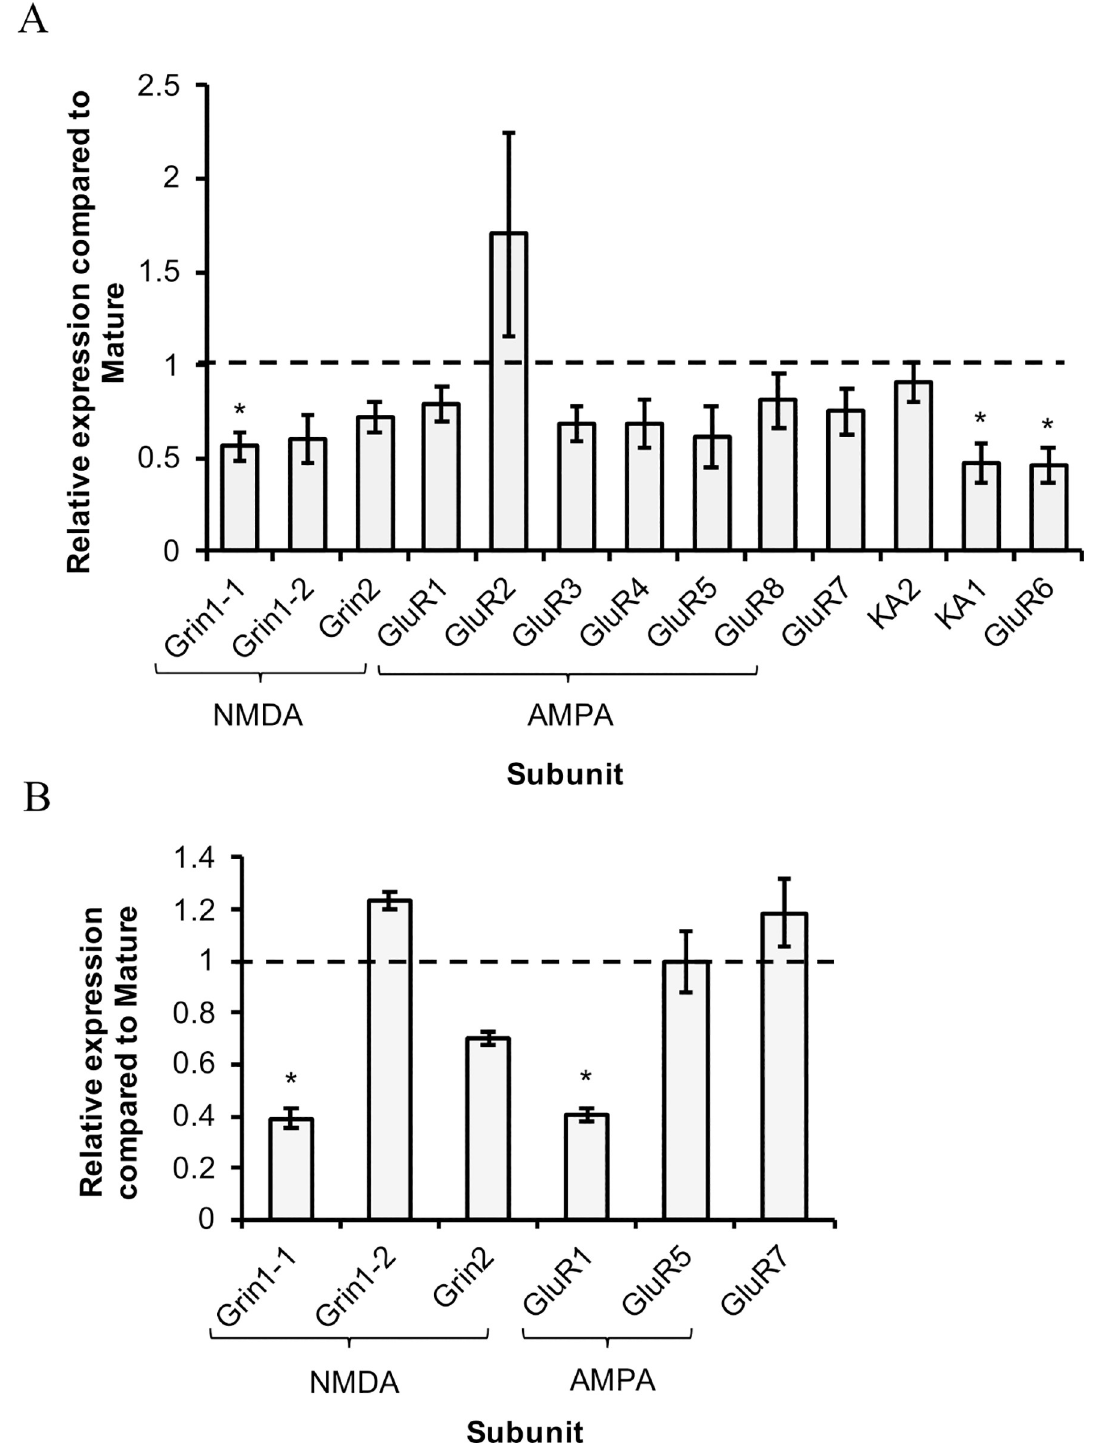
Fig 1. Relative expression of iGluR subunits in PVC sensory neurons with age. A) Relative expression for all iGluR subunits in AII compared to M (dotted line) in cohort 1. B) Relative expression of select iGluR subunits in cohort 2 AII compared to M (dotted line). All data are presented as mean relative expression ± SEM. � denotes significantly reduced expression compared to M (p � 0.05, two-way ANOVA, Tukey’s post hoc; n = 6 for cohort 1, n = 4 for cohort 2).